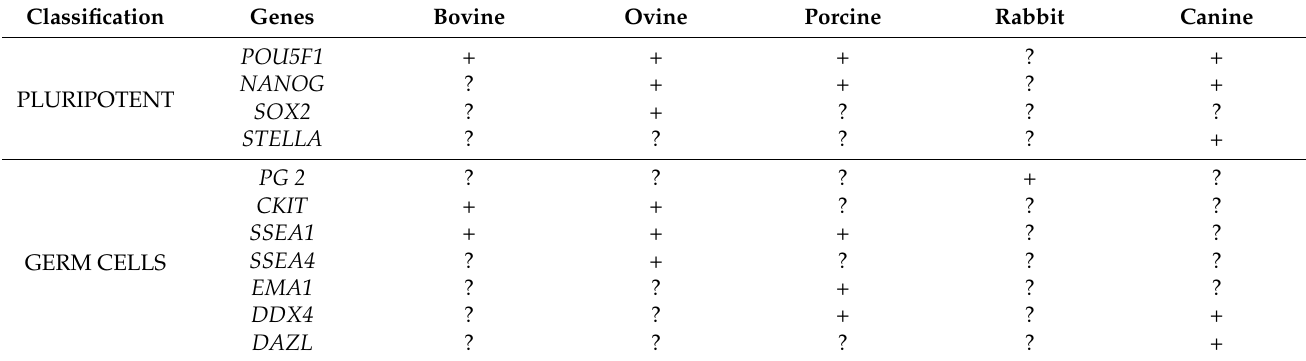
Table 3. A summary of relevant genes for the specification of domestic animals